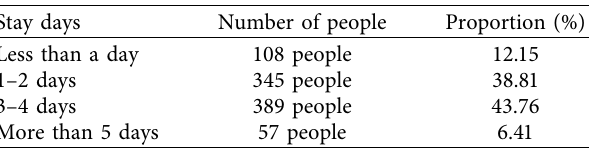
Figure 8: Statistical (a) analysis of (b) consumer situation. Table 3: Statistical analysis table of destination stay time of sports tourism